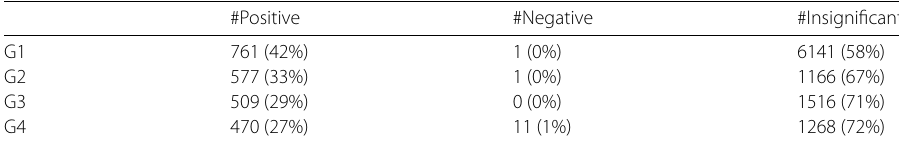
Table 11 Dependence of the susceptibility distribution on the posting rate for Reddit. The users are divided into four equal-sized groups (G1, G2, G3, and G4) based on their posting rate #Positive #Negative G1